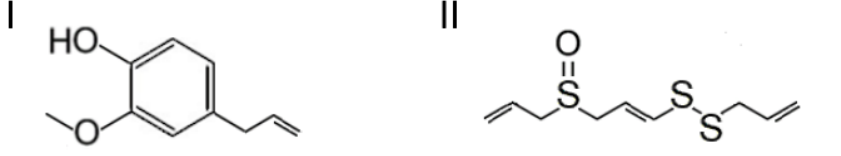
Figure 3. Structure of plant-derived QS inhibitors. ( I ) Eugenol (from cloves and cinnamon); ( II ) Ajoene (from garlic).